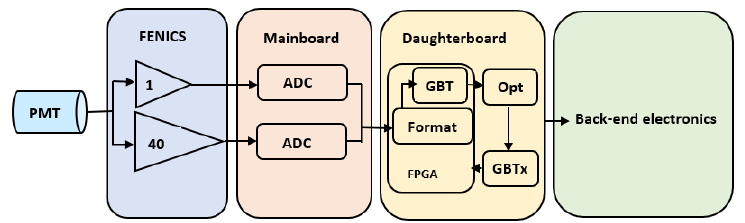
Figure 1: The TileCal HL-LHC front-end readout